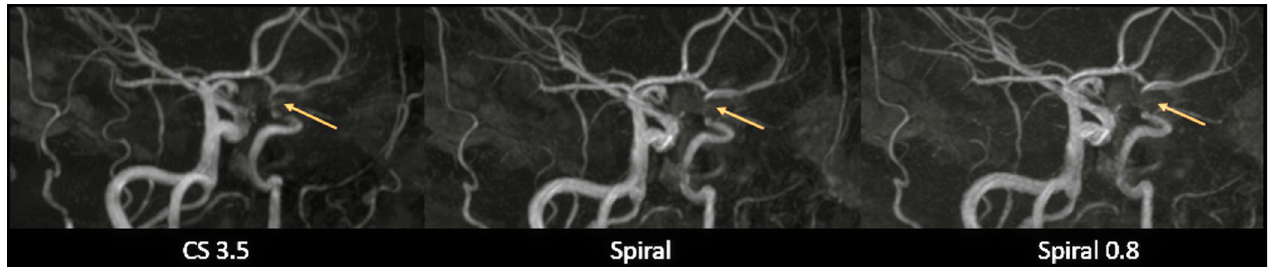
Fig 5. MIP images showing supraclinoid internal carotid artery occlusion on all three sequences with slightly improved visualization on Spiral and Spiral 0.8 images.